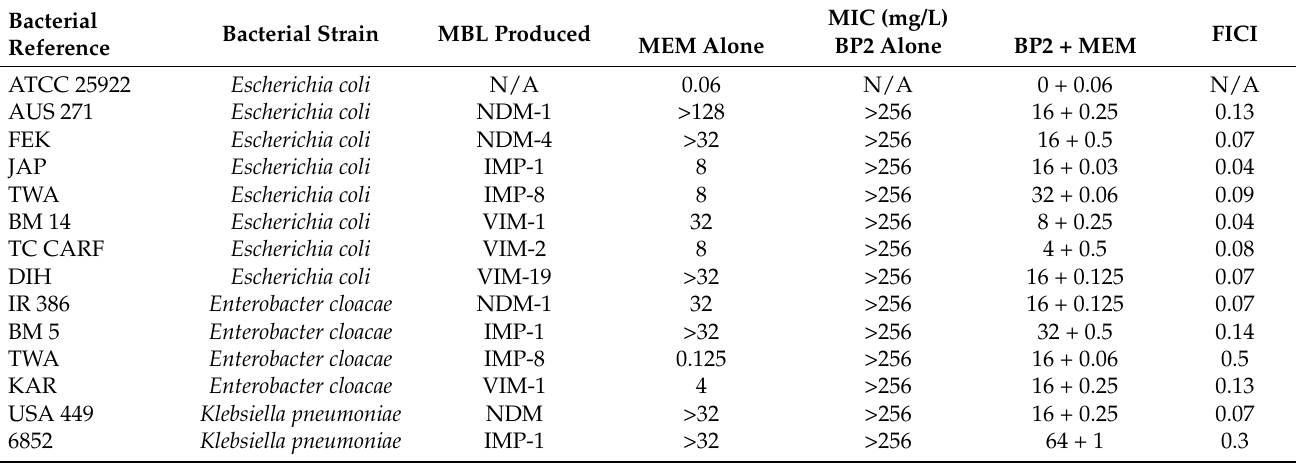
Table 1. The MICs of BP2 and meropenem alone or in combination, from a panel of 21 carbapenem-resistant